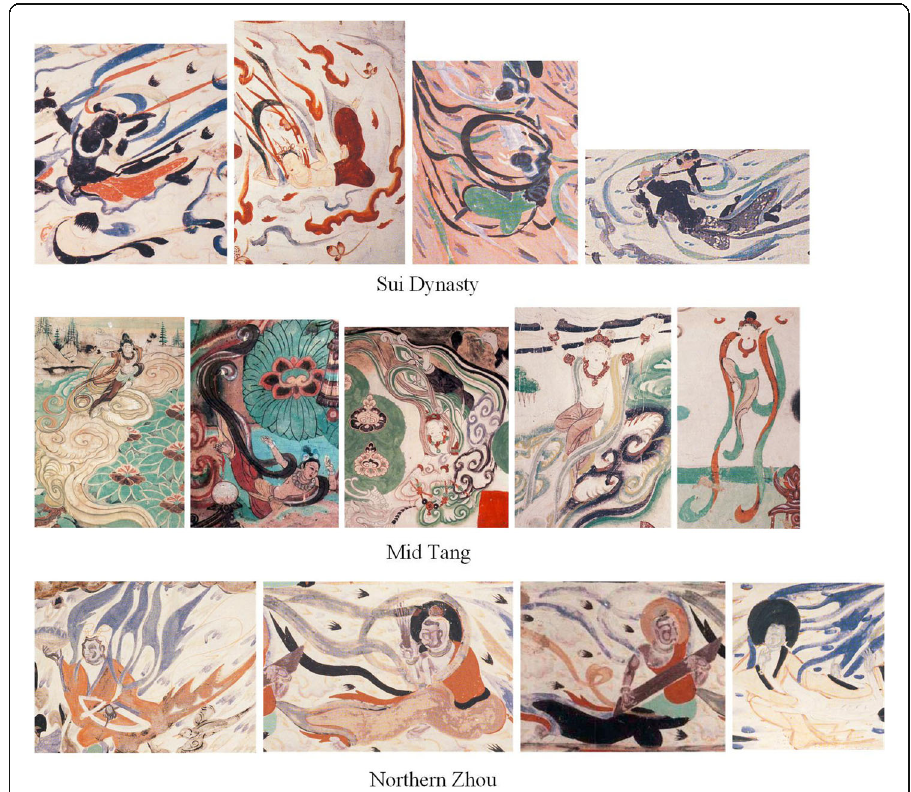
Fig. 15 Some examples of the Flying Apsaras mural